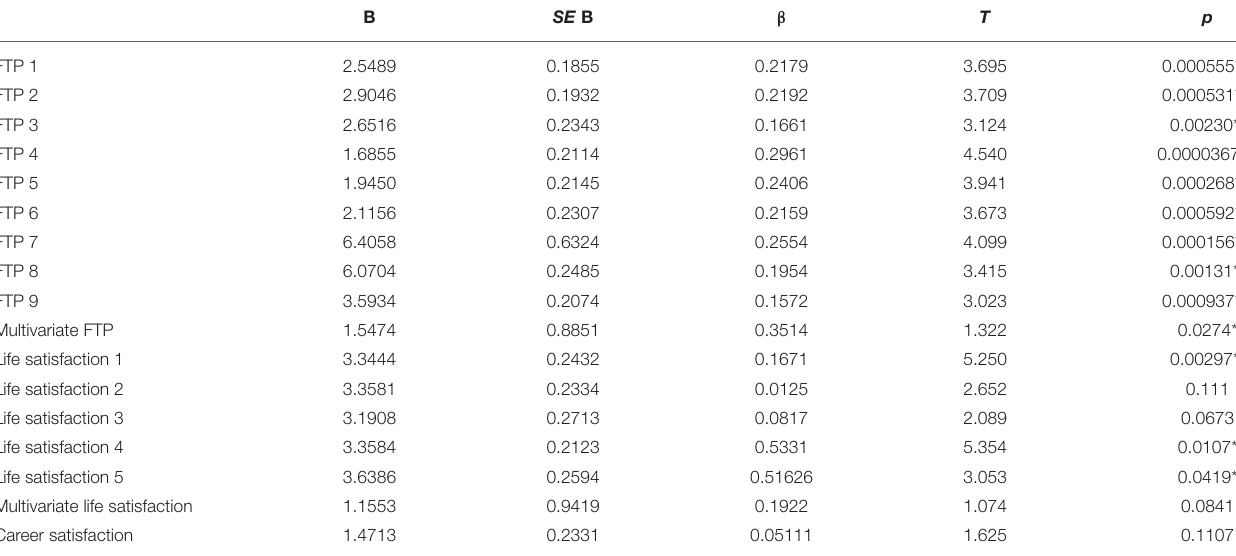
TABLE 3 | Logistic regression between the question “how close is your relationship with your musician colleagues?” and measures of future time perspective (FTP), life satisfaction, and career